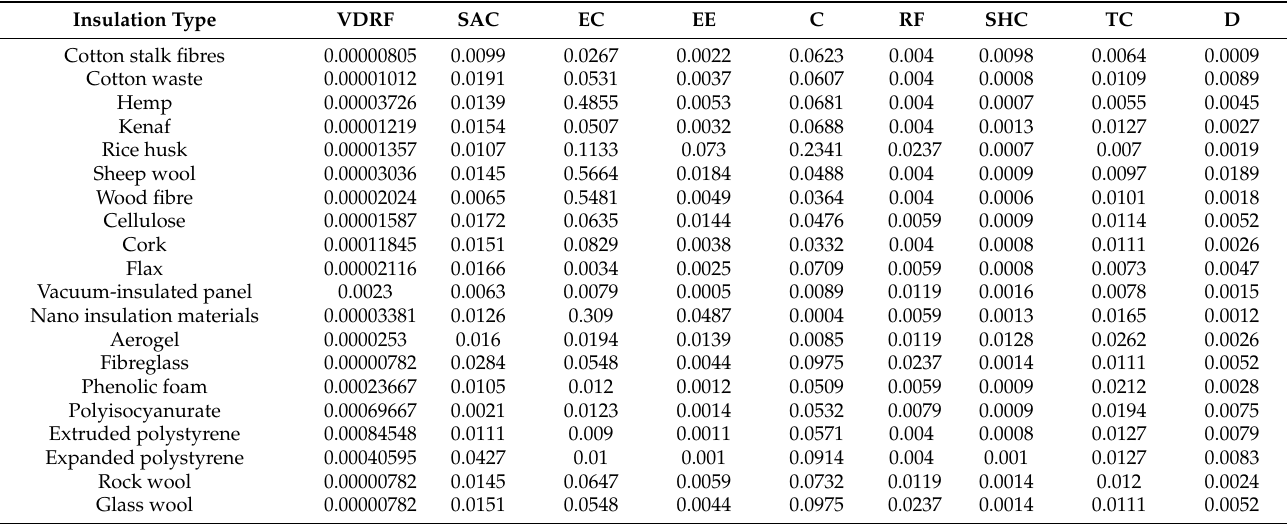
Table 8. Weighted normalised